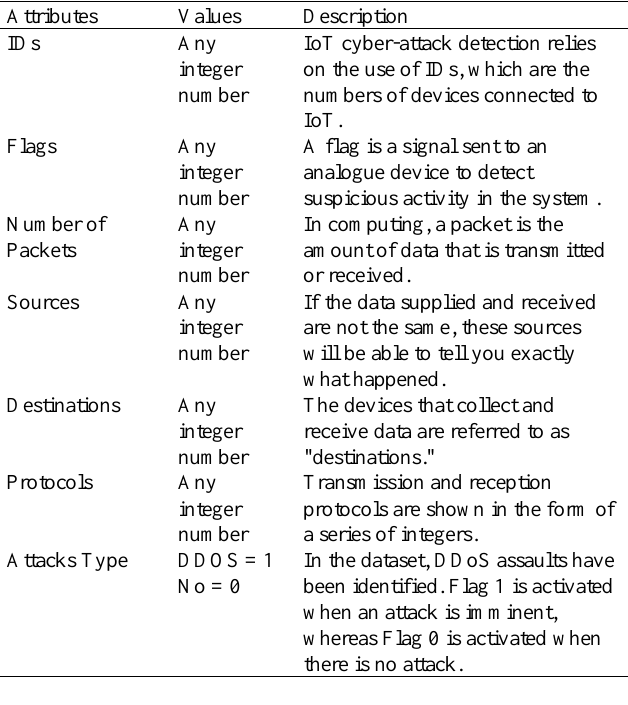
Figure 1. Proposed Flow Work